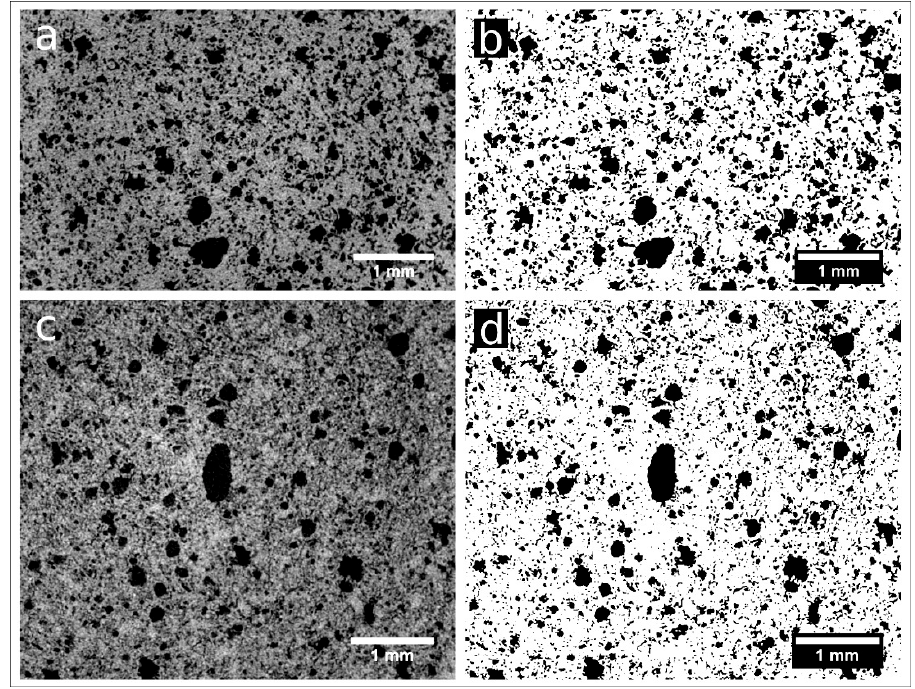
Figure 6. Reconstructed axial slices of samples nPC1450d ( a ) and nPC1350d ( c ) after the application of an anisotropic diffusion. ( b ) and ( d ) show the binary images of the same slices obtained by 3D segmentation (pores in white, background in black).